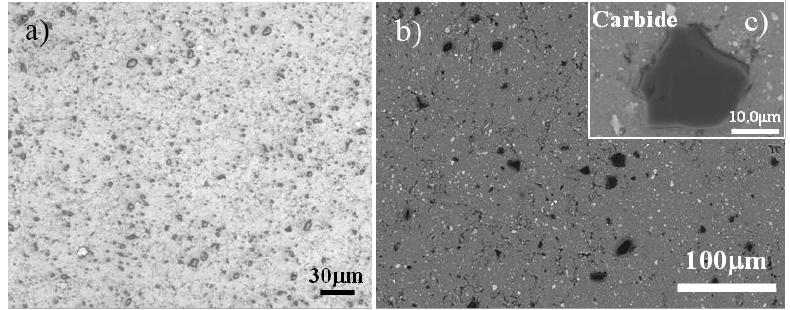
Figure 4. Al2024-2.0 wt.% B 4 C specimen milled for 2 h, sintered and T6 heat treated: ( a ) low-magnification optical micrograph and ( b ) high-magnification SEM micrograph; ( c ) morphology of a single B 4 C particle.